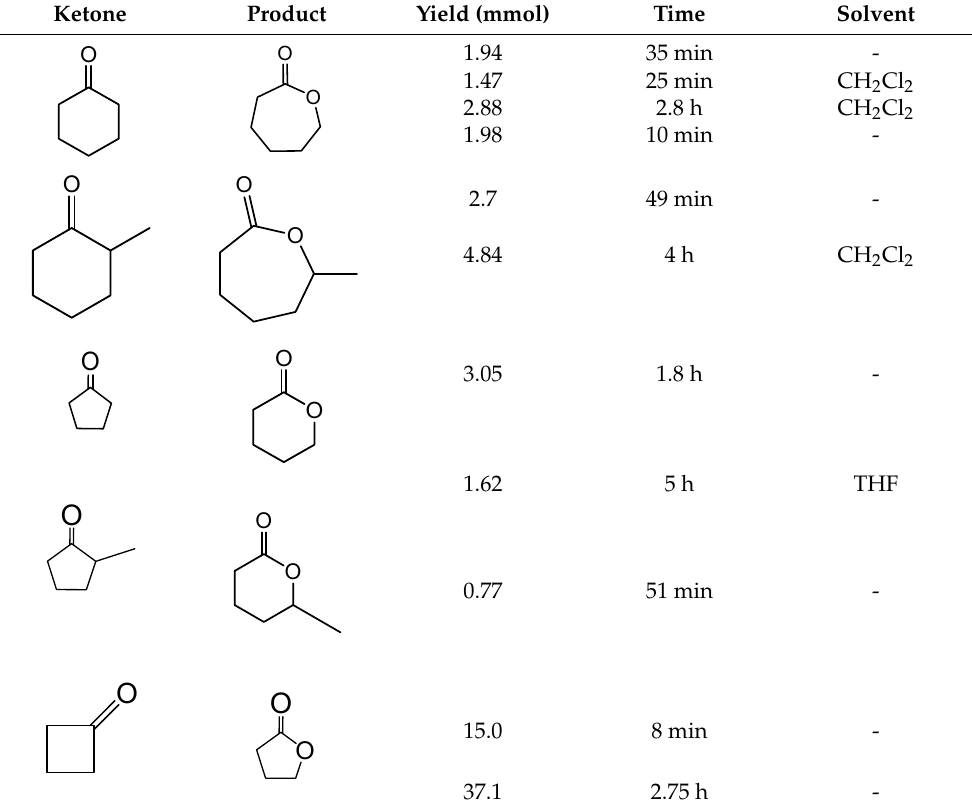
Table 2. Catalytic performance of (P-P)Pt(CF 3 )X for the oxidation of cyclic ketones to lactones.